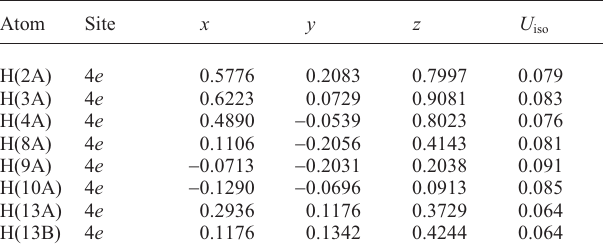
Table 2. Atomic coordinates and displacement parameters (in Å 2 )